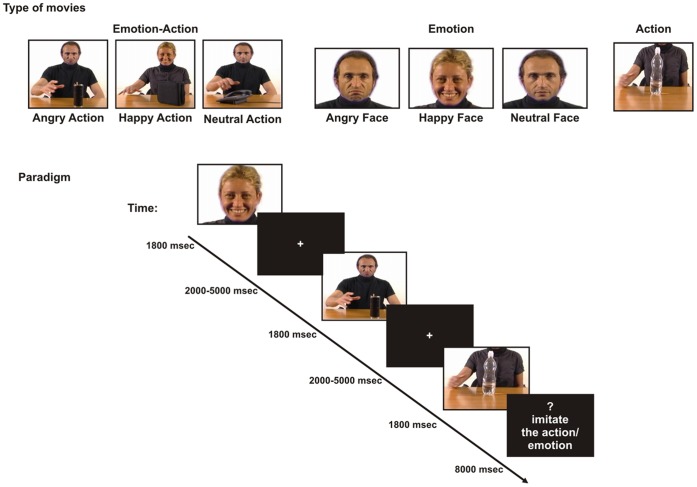
Stimuli and experimental paradigm.Examples of the three sets of coloured movies used in the visual stimulation. Lower panel: description of the experimental paradigm.